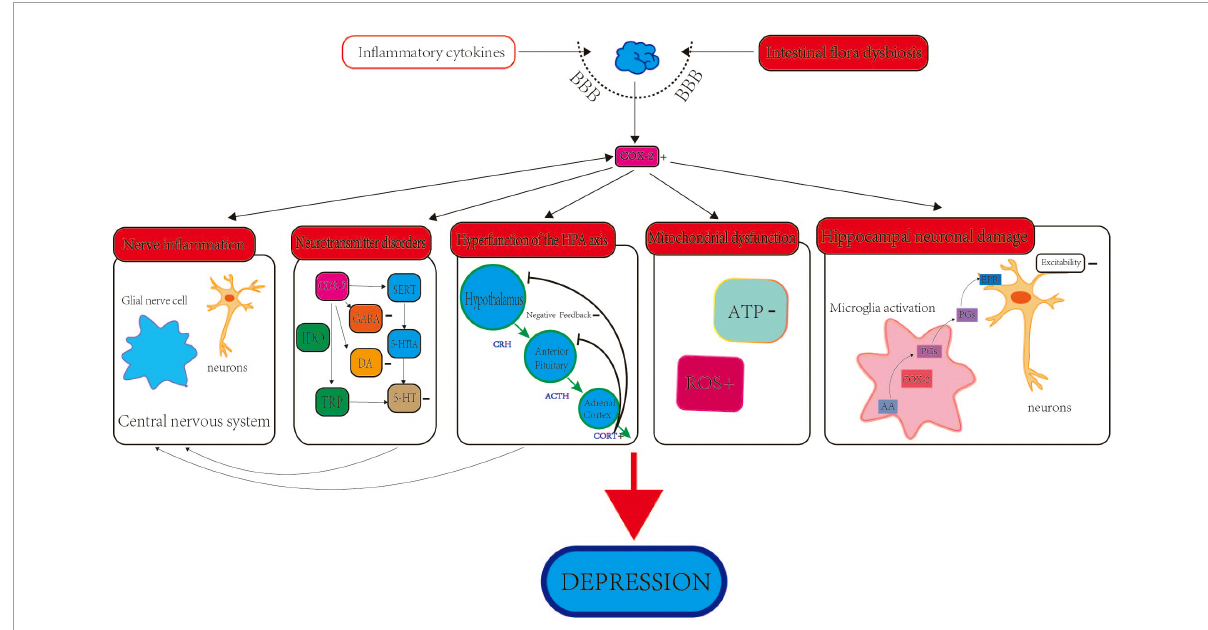
FIGURE1 The role and mechanism of COX-2 in depression. The role of COX-2 and depression involves several aspects, including neuroinflammation, intestinal flora, neurotransmitters, HPA axis, deregulation of mitochondrial functions and neuronal damage of